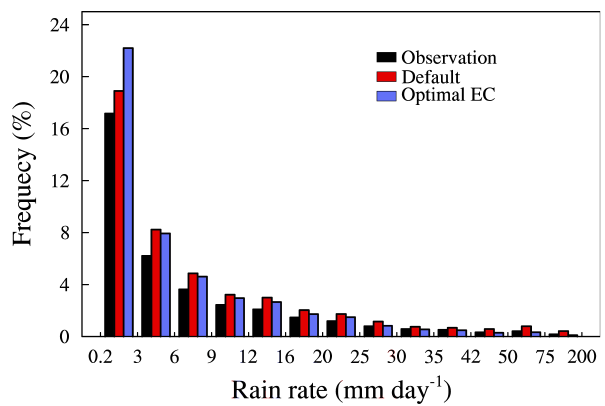
Fig. 6. The observed and simulated (25km) frequency distributions of daily precipitation over SGP as a function of rain rates, with de- fault and optimized (based on EC ) parameters in the KF scheme. The result is derived from daily precipitation at all grids within the model domain as shown in Fig. 2 for June